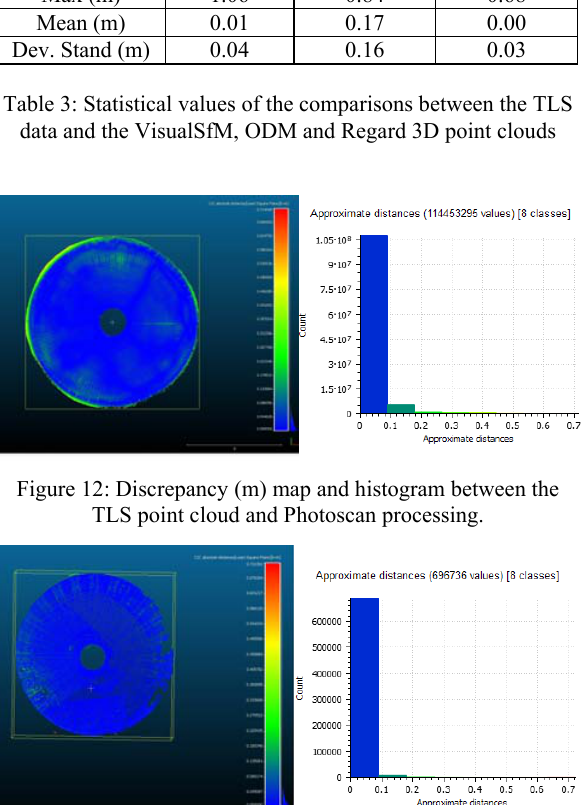
Figure 11: TLS point cloud